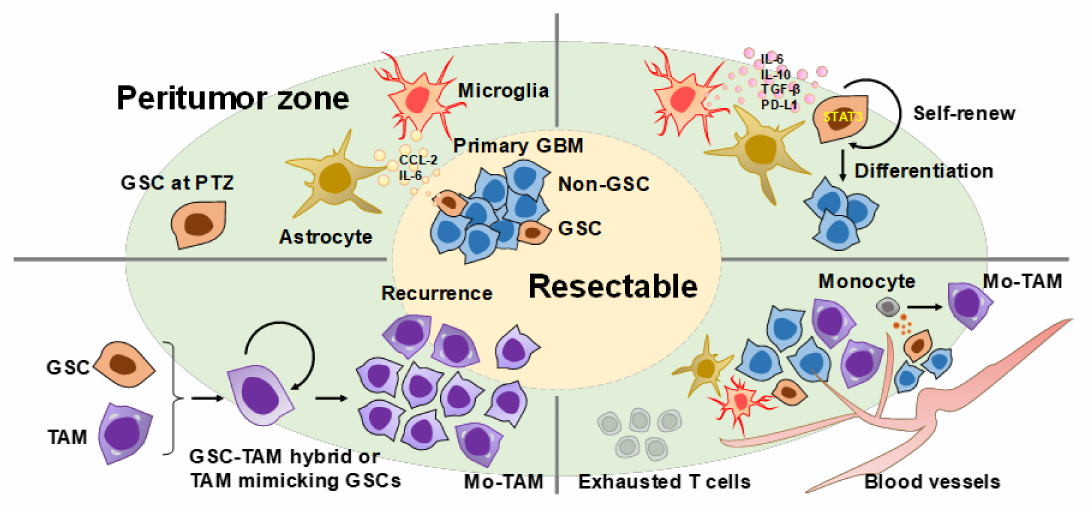
Figure 1. The putative footsteps of how GSCs complete recurrence. In primary GBM, GSCs release cues (e.g., CCL-2 and IL-6) to induce reactive astrocytes and microglia (top left). Surgical resection can remove the primary tumor at the resectable zone. However, GSCs remained at the peritumor zone (PTZ). GSCs at PTZ receive cues (e.g., IL-6, IL-10, TGF- β , and PD-L1) from reactive glial cells and start to regrow or self-renew to generate their differentiated progenies (top right). Once GSCs have grown to a certain extent, GSCs arrange their suitable microenvironment by recruiting monocytes derived from bone marrow and mediate their differentiation into tumor-associated macrophages (TAM). A variety of immune cells are infiltrated in the GBM tissue, but the anti-tumor immune compartments are mostly exhausted (bottom right). GSCs are further being progressive with the virtue of not well-proven mechanisms (e.g., TAM–GBM hybrids) to complete recurrence (bottom